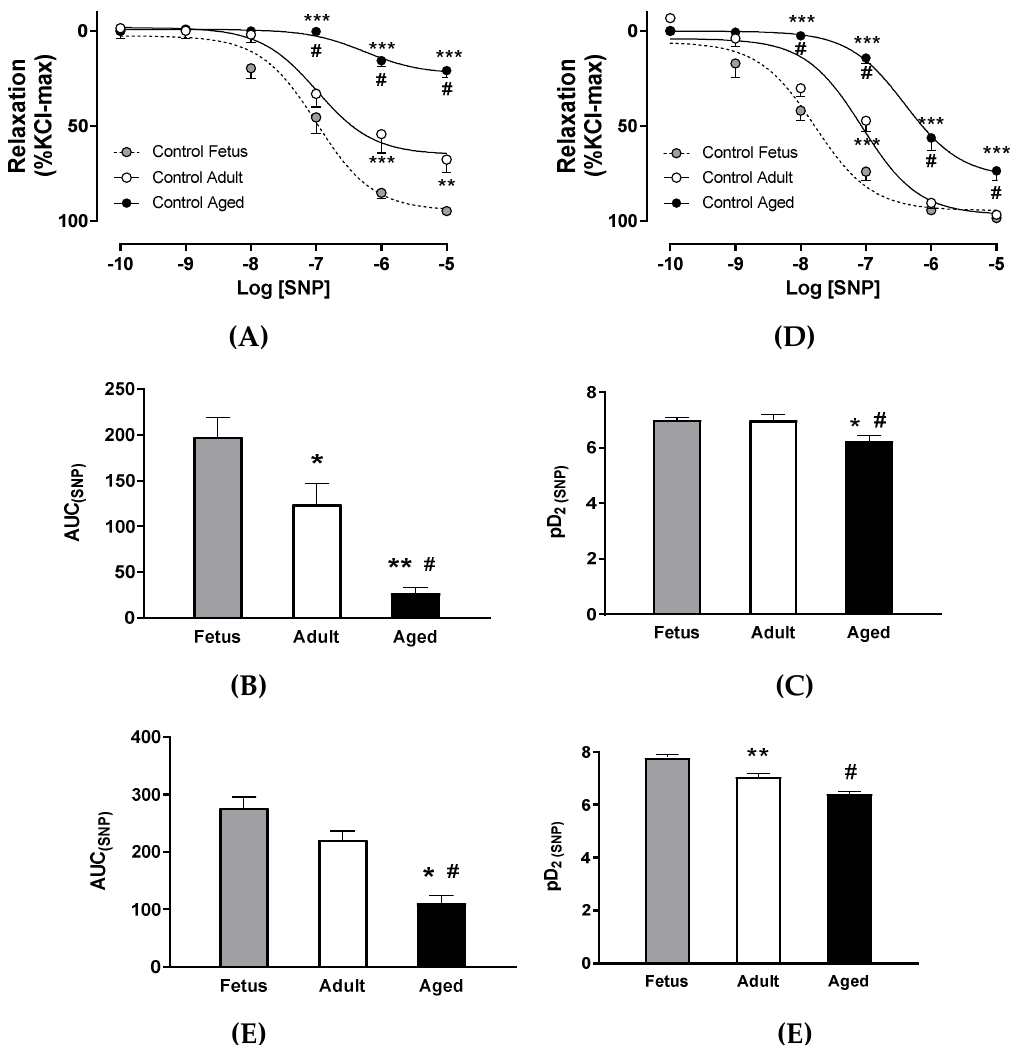
Figure 3. Ex vivo NO-dependent relaxation in arteries from fetal to aged guinea pigs. Concentration-dependent relaxation in response to sodium nitroprusside (SNP) in carotid ( A ) and femoral arteries ( D ) from control fetus (gray circles, dashed black lines), control adult (open circles, continuous black lines), and control aged guinea pigs (solid circles, continuous black lines). Area under curve and pharmacological potency (pD 2 , i.e., sensitivity) of acetylcholine in carotid ( B , C , respectively) and femoral arteries ( E , F ) from control fetus (gray bar), control adult (open bar), and control aged guinea pigs (black bar). Values are expressed in mean ± SEM.* p < 0.05, ** p < 0.01, *** p < 0.001 vs term fetus. # p < 0.05 vs adult. ANOVA.